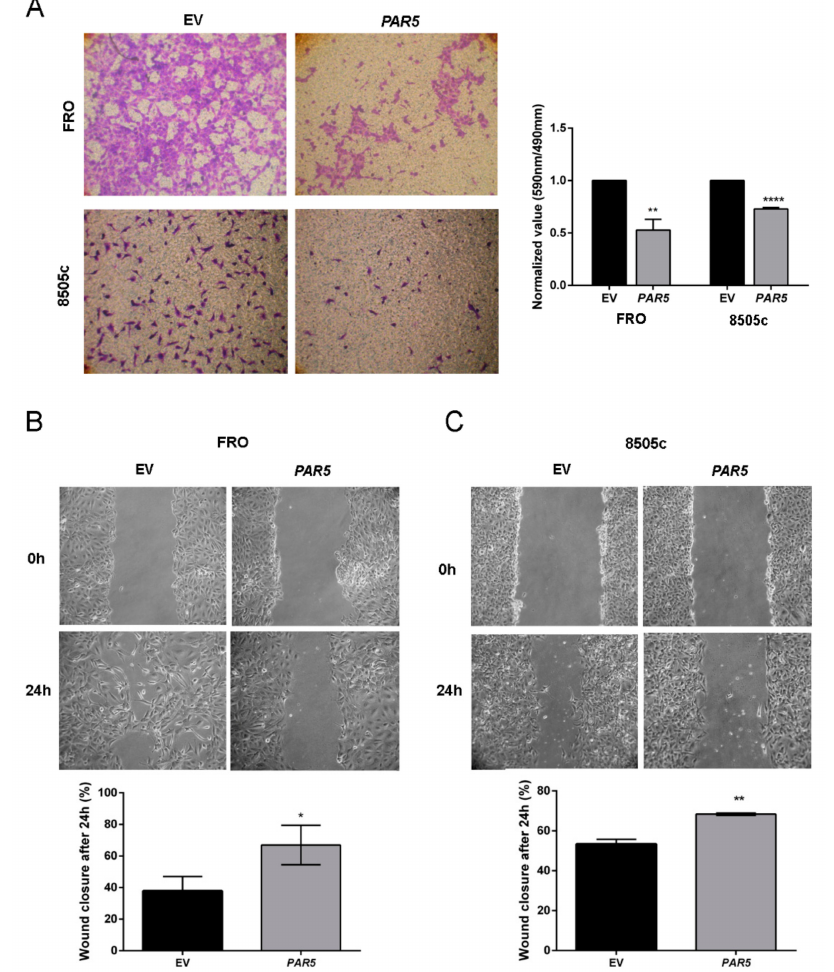
Figure 4. PAR5 suppresses cell migration of ATC cell lines. ( A ) Representative images of migration assay performed in FRO and 8505c cells stably transfected with PAR5 or the corresponding EV (left panel). Magnification 40 × . Migrating cells were fixed with crystal violet solution. After elution from transwell, it was quantified by reading its absorbance at 590 nm. Crystal violet absorbance values were divided by corresponding cell titer values. In the right panel data obtained from three independent experiments carried out in FRO and 8505c cells are shown. Values are reported as mean value ± SD, compared to the EV, set equal to 1. Unpaired t -test: **, p < 0.01 ( PAR5 vs. EV, in FRO cells), ****, p < 0.0001 ( PAR5 vs. EV, in 8505c cells). ( B , C ) A representative image of scratch wound-healing assay performed in FRO and 8505c cells stably carrying PAR5 or the corresponding EV is reported in the upper panel. t = 0 h and t = 24 h post wounding. Magnification 40 × . In the lower panel is reported the percentages of closures of the wound after 24 h in FRO and 8505c cells stably expressing PAR5 or carrying the corresponding EV. Data are presented as the average of three experiments. *, p < 0.05 in FRO cell line, PAR5 vs. EV, after 24 h, **, p < 0.01 in 8505c cell line after 24